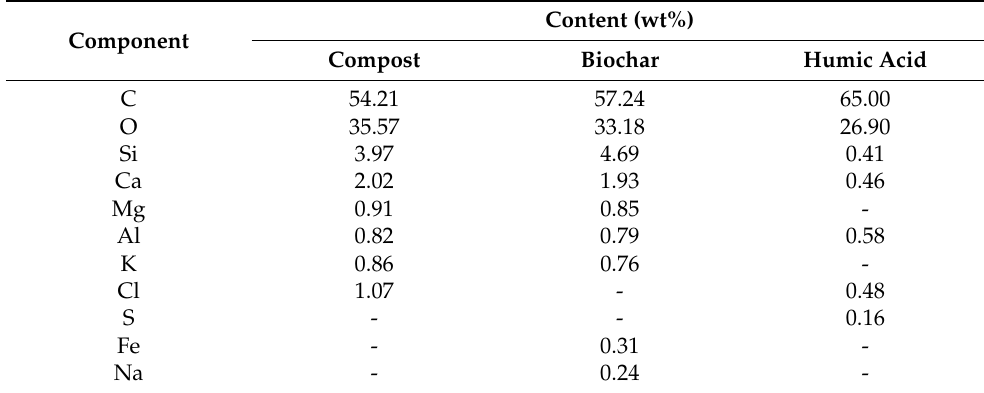
Table 1. Material composition based on SEM-EDX